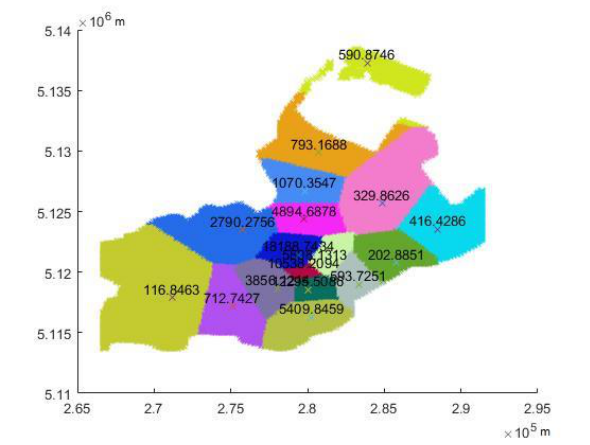
Figure (2) Output clusters of the clustering process Clustering steps may result in cold spot clusters. To eliminate the cold stop, all of the clusters with the mean of lower than the third quarter of the entire data are removed. The result of the hot spot areas and their centroids are shown in Figure (3).